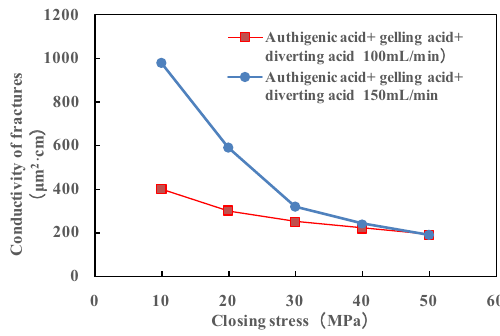
Fig. 5 Comparison of conductivity of acid-etched fractures at dif- ferent flow